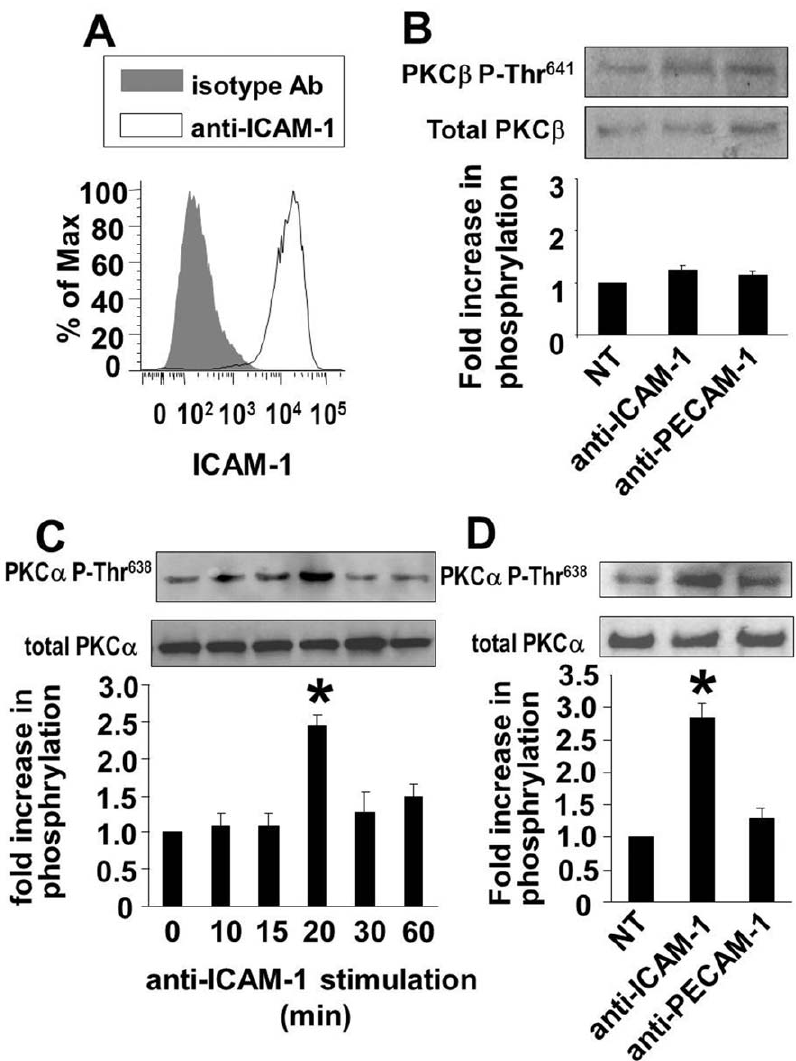
Figure 1. ICAM-1 activates PKC a but not PKC b II in HMVECLs. A ) At 70% confluence, HMVECLs cells pretreated with 10 ng/ml TNF a to induce ICAM-1 expression. At 24 hrs, the cells were suspended and immunolabeled with anti-ICAM-1 antibodies and examined by flow cytometry for